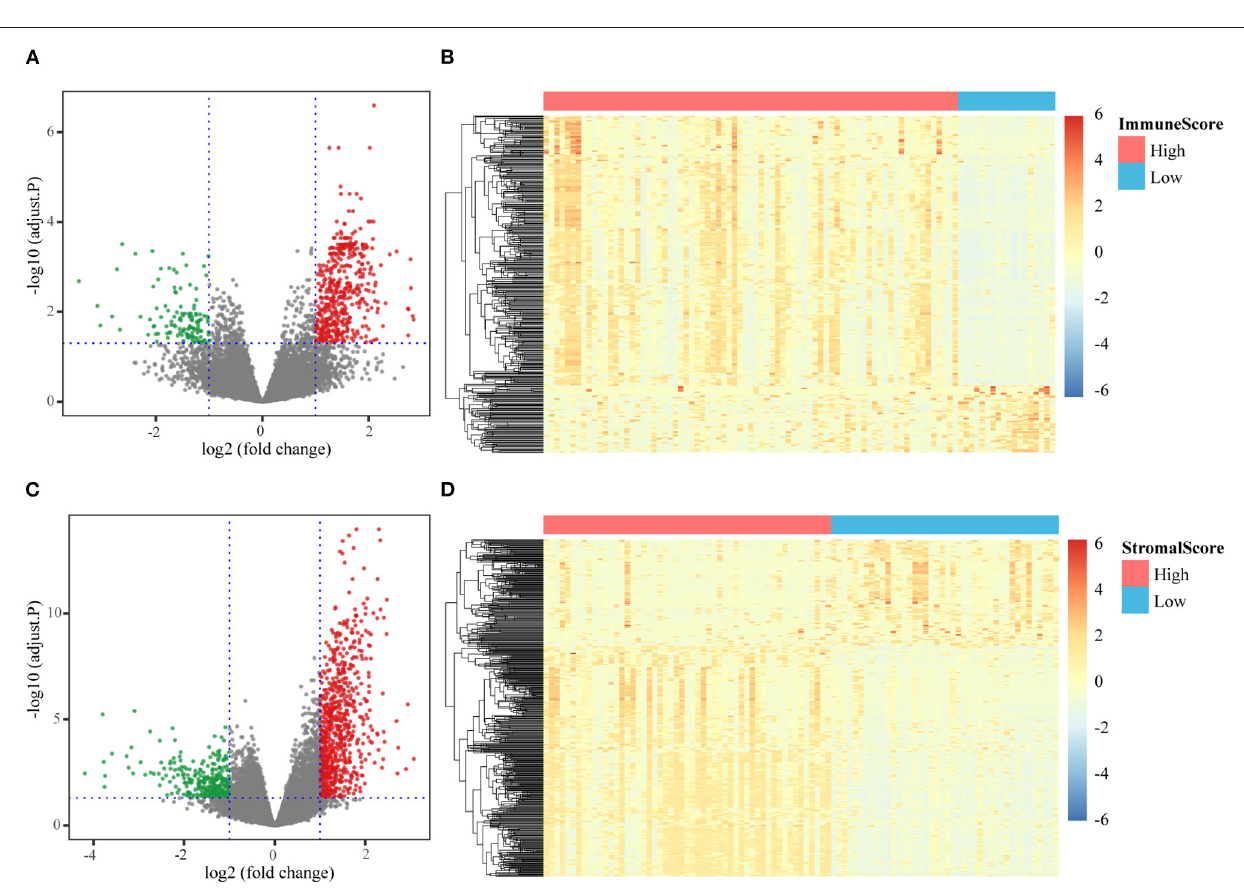
FIGURE 2 | Different expression genes identification. (A) Volcanic diagram of DEGs based on the comparison of high/low immune scores; (B) expression levels of DEGs based on the comparison of high/low immune scores; (C) volcanic diagram of DEGs based on the comparison of high/low stromal scores; (D) expression levels of DEGs based on the comparison of high/low stromal